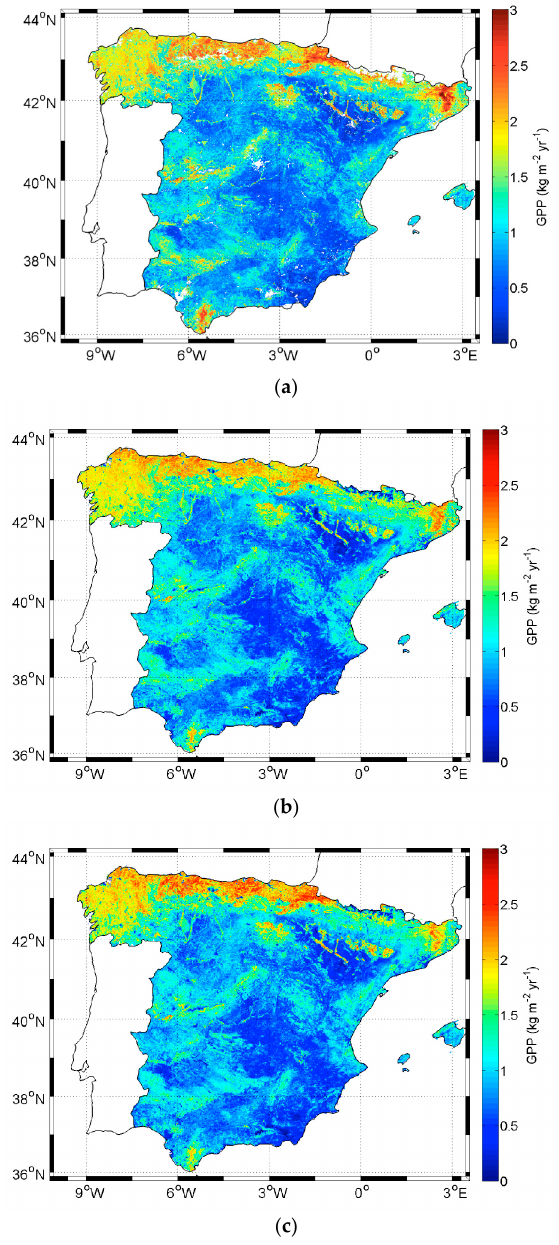
Figure 7. ( a ) Reference annual GPP and estimated GPP annual (in kg · m − 2 · yr − 1 ) for 2011 using: ( b ) NDVI; and ( c ) EVI.